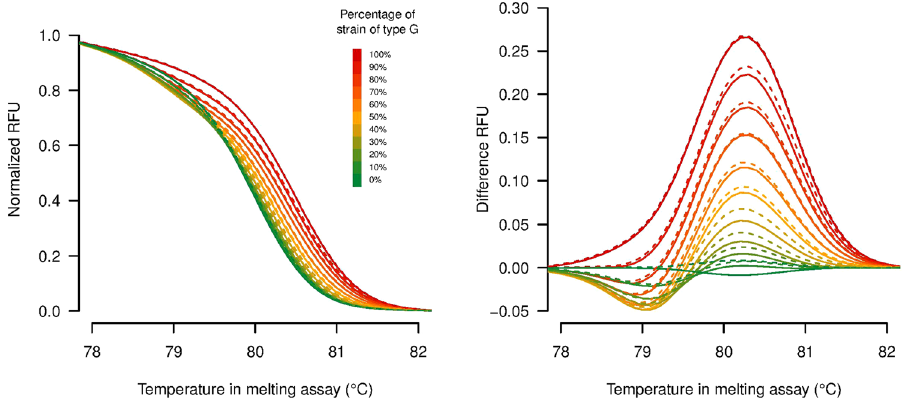
Figure 2. (Right) Normalized melting curves and (Left) difference plots of reference samples consisting of purified DNA from genotypes G and A pooled in known proportions (13 different proportions of the two